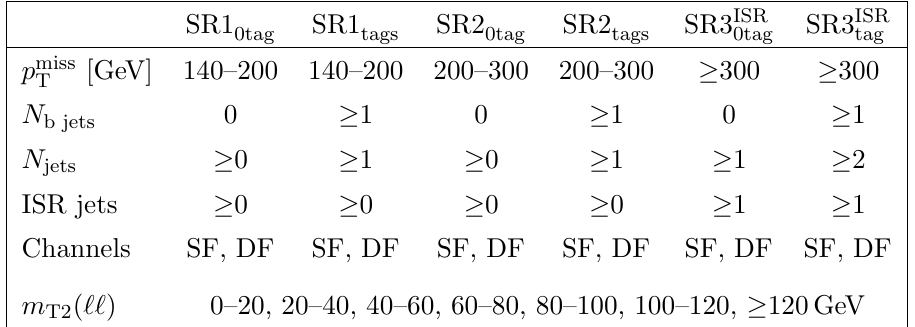
Table 3 . De(cid:12)nition of the SRs for top squark production search as a function of the p miss the b-jet multiplicity and the ISR jet requirement. Each of the regions is further divided in seven m T2 ( ‘‘ ) bins as described in the last